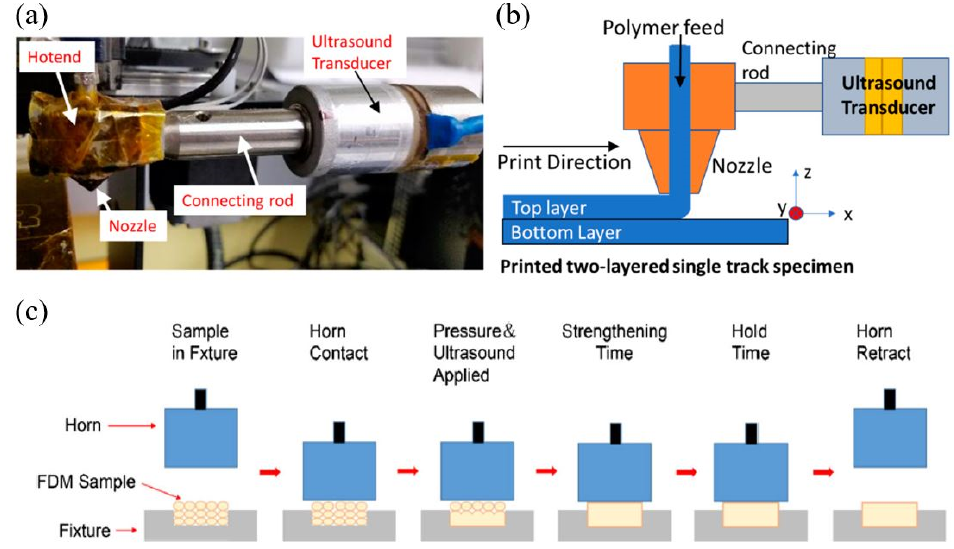
Figure 22. ( a ) Ultrasonic transducer attached to the printing head. ( b ) Schematic diagram of the apparatus. ( c ) Ultrasound horn setup. ( a ), ( b ): [256], ( c ): [257]. apparatus. ( c ) Ultrasound horn setup. ( a , b ): [256], ( c ):